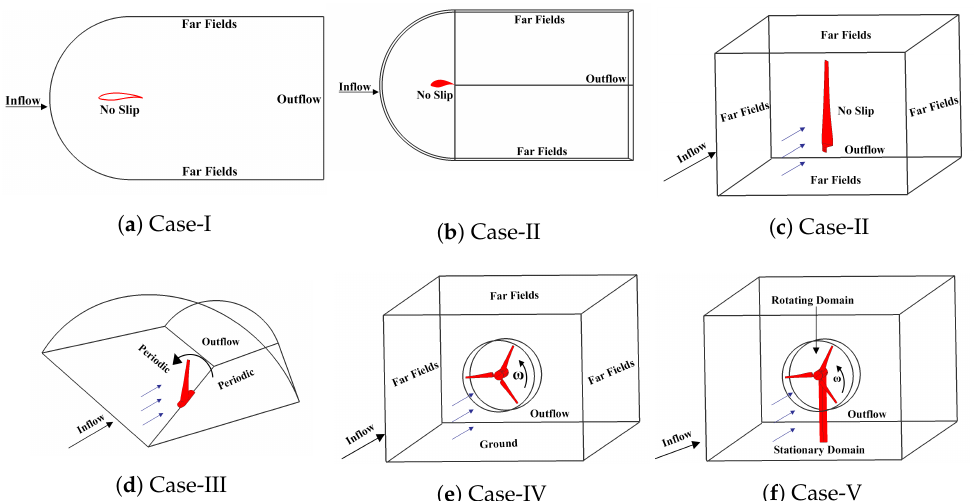
Figure 4. HAWT-S826: Schematics of the geometric approximation with descriptions of the flow directions, flow fields and boundary conditions. Six levels of geometric complexities were considered, i.e., a 2D airfoil (Case-I), 2.5D blade section, 3D full blade (Case-II), 120 ◦ blade (Case-III), 360 ◦